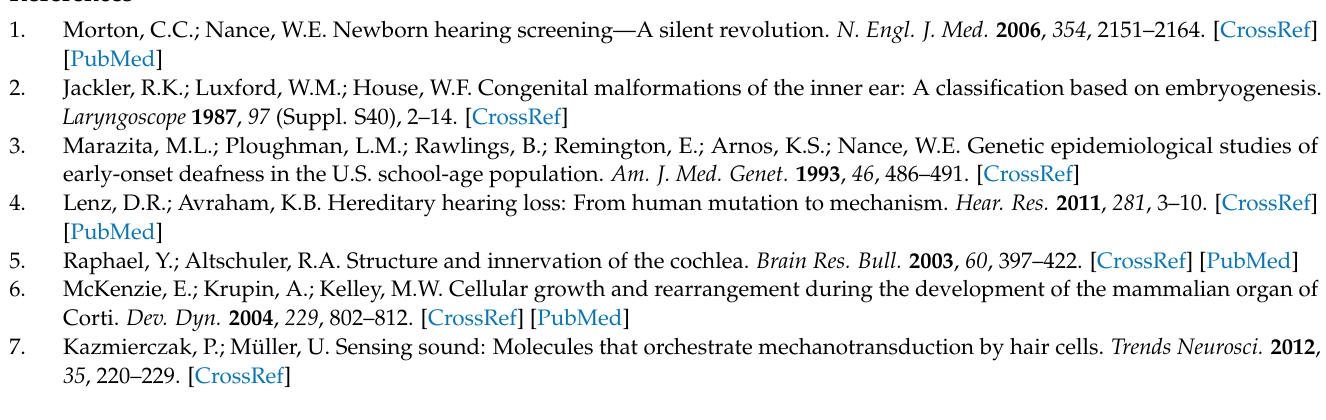
Figure S3: The normal hearing and normal hair cells in adult Dmp1 cKD mice. Figure S4: 1st-dmp1. Figure S5: 1st-gapdh. Figure S6: 2st-dmp1. Figure S7: 2st-gapdh. Figure S8: 3st-dmp1. Figure S9: